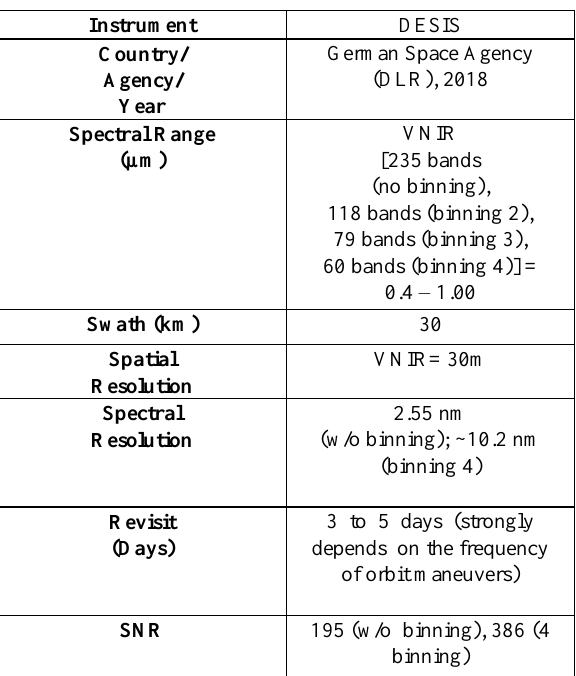
Table 1 . Specifications of DESIS hyperspectral